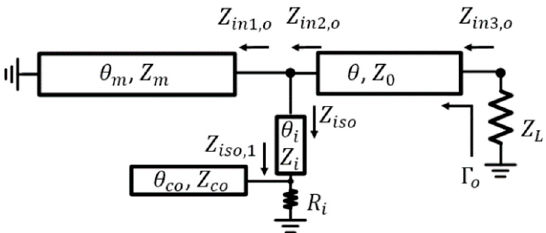
Figure 3. Bisected network with short-circuit bisecting plane at the plane of symmetry for odd-mode analysis.